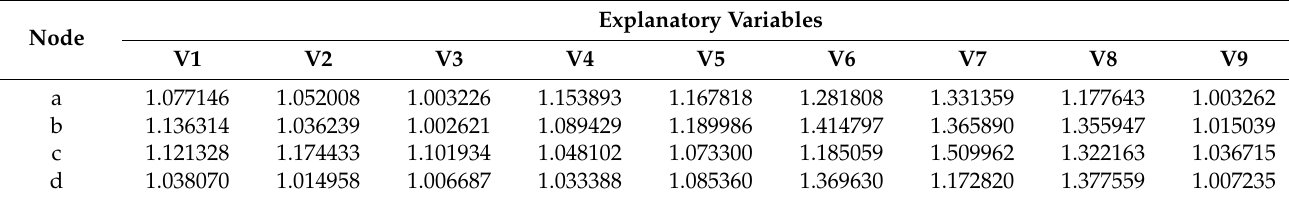
Table 5. VIF values of each explanatory variable in the research station